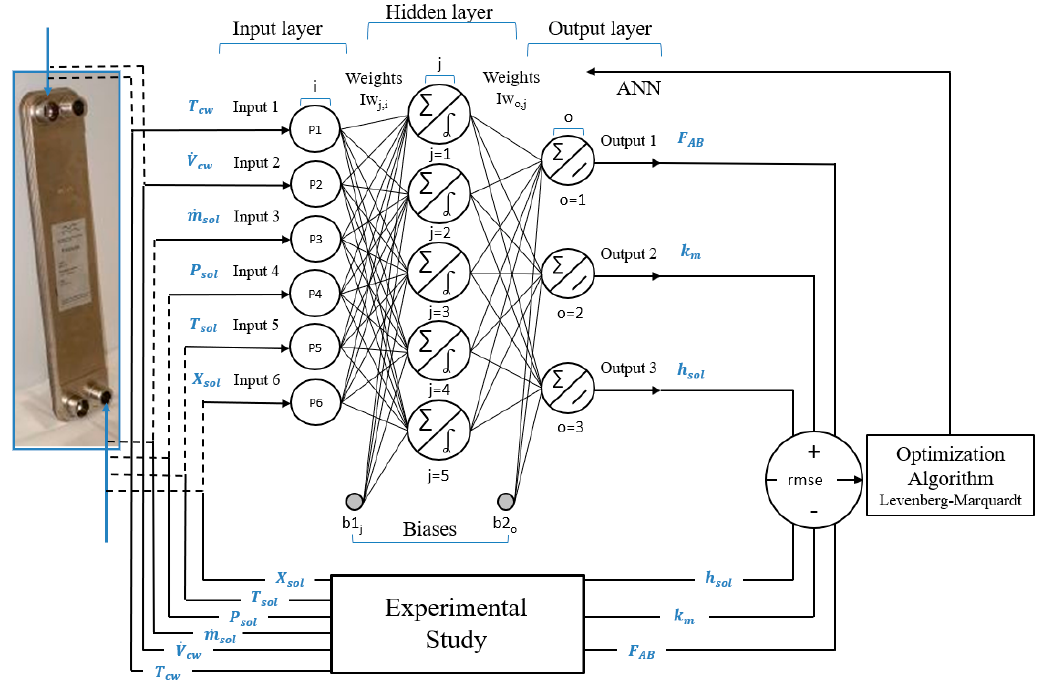
Figure 7. Design of the artificial neural network (ANN) structure used to assess the PHE absorber.